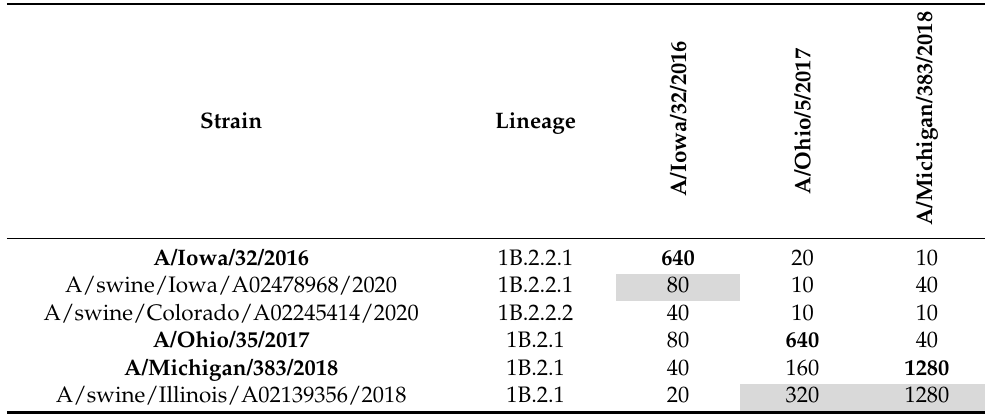
Table 3. Antigenic cross-reactivity of 1B viruses and within-clade CVVs. Ferret antisera raised against CVV were tested for the ability to inhibit hemagglutination of contemporary swine viruses. Vaccine strains and homologous titers are bolded; grey highlighted cells indicate the within-clade titer of contemporary swine